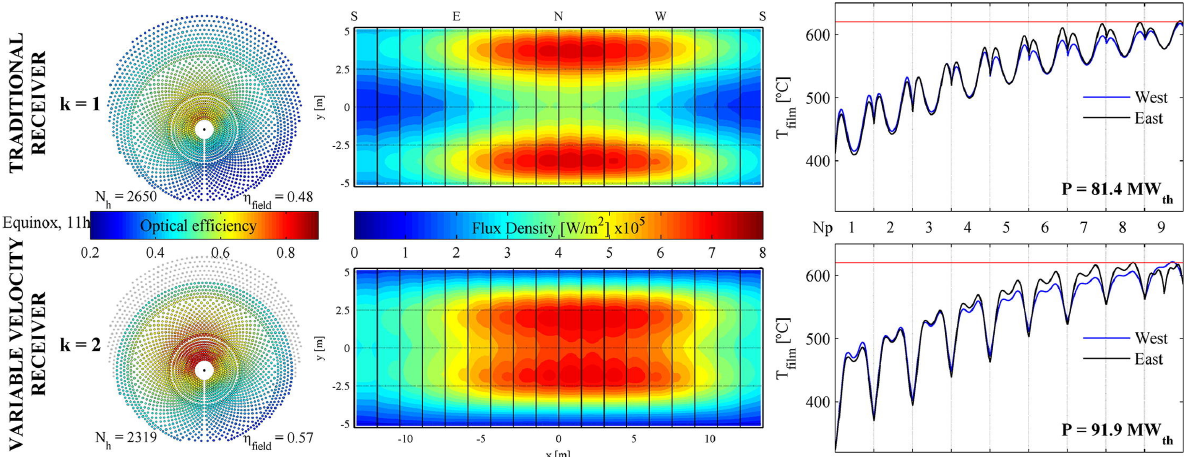
Fig. 2: Operation of the novel Variable Velocity Receiver proposed in [75] vs. a Traditional External Tubular Receiver. Reprinted from Applied Thermal Engineering, Vol. 128, M.R. Rodríguez-Sánchez, A. Sánchez-González, D. Santana, Feasibility study of a new concept of solar exter- nal receiver: Variable velocity receiver, Pages No. 335-344, Copyright (2018), with permission from Elsevier.